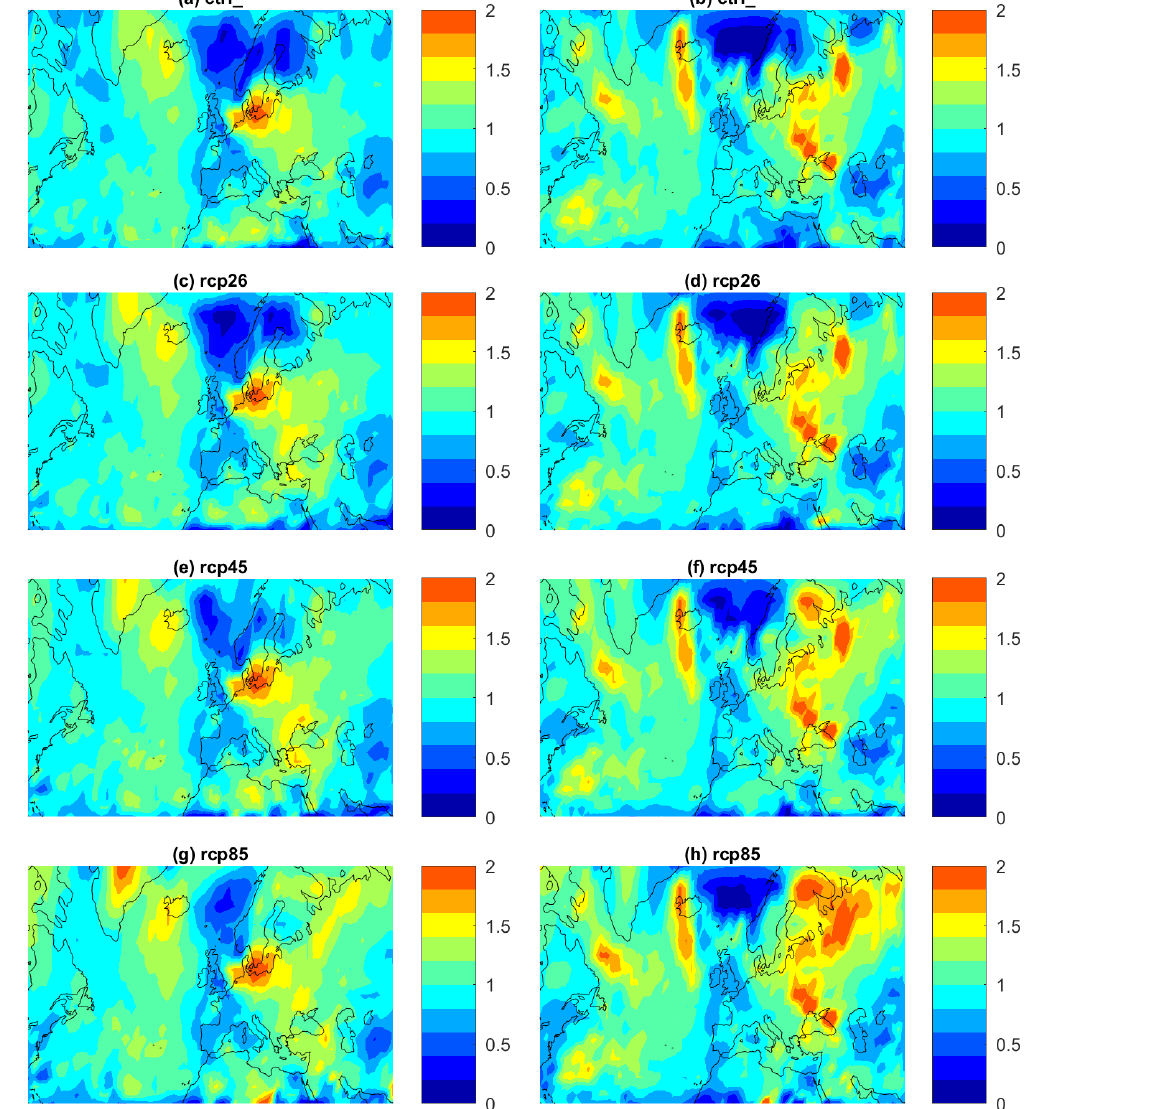
Figure B5. Daily precipitation rate uncertainty in PlaSim analogues: root mean squared difference in standardized daily precipitation rates (standard deviations) between analogues and cluster centroids for cluster 1 (a, c, e, g) and cluster 2 (b, d, f, h) . (a, b) Control run. (c, d) RCP2.6 run. (e, f) RCP4.5 run. (g, h) RCP8.5